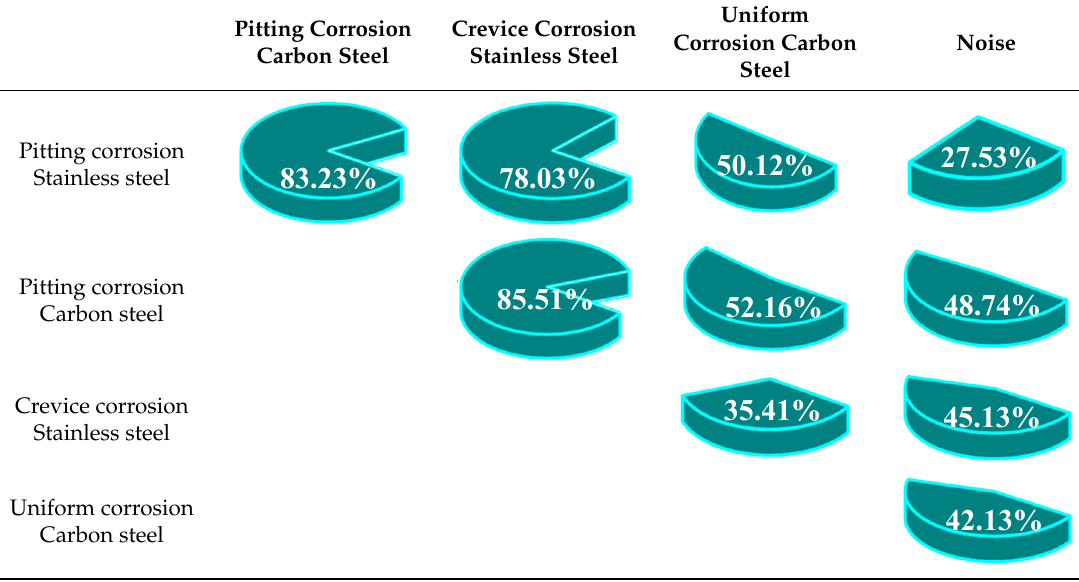
Figure 11. Different continuous AE graphics: ( a ) pitting corrosion of carbon steel, ( b ) pitting corrosion of stainless steel, ( c ) crevice corrosion of stainless steel, ( d ) uniform corrosion of carbon steel, ( e ) noise. Table 3. The similarity of the different types of corrosion.